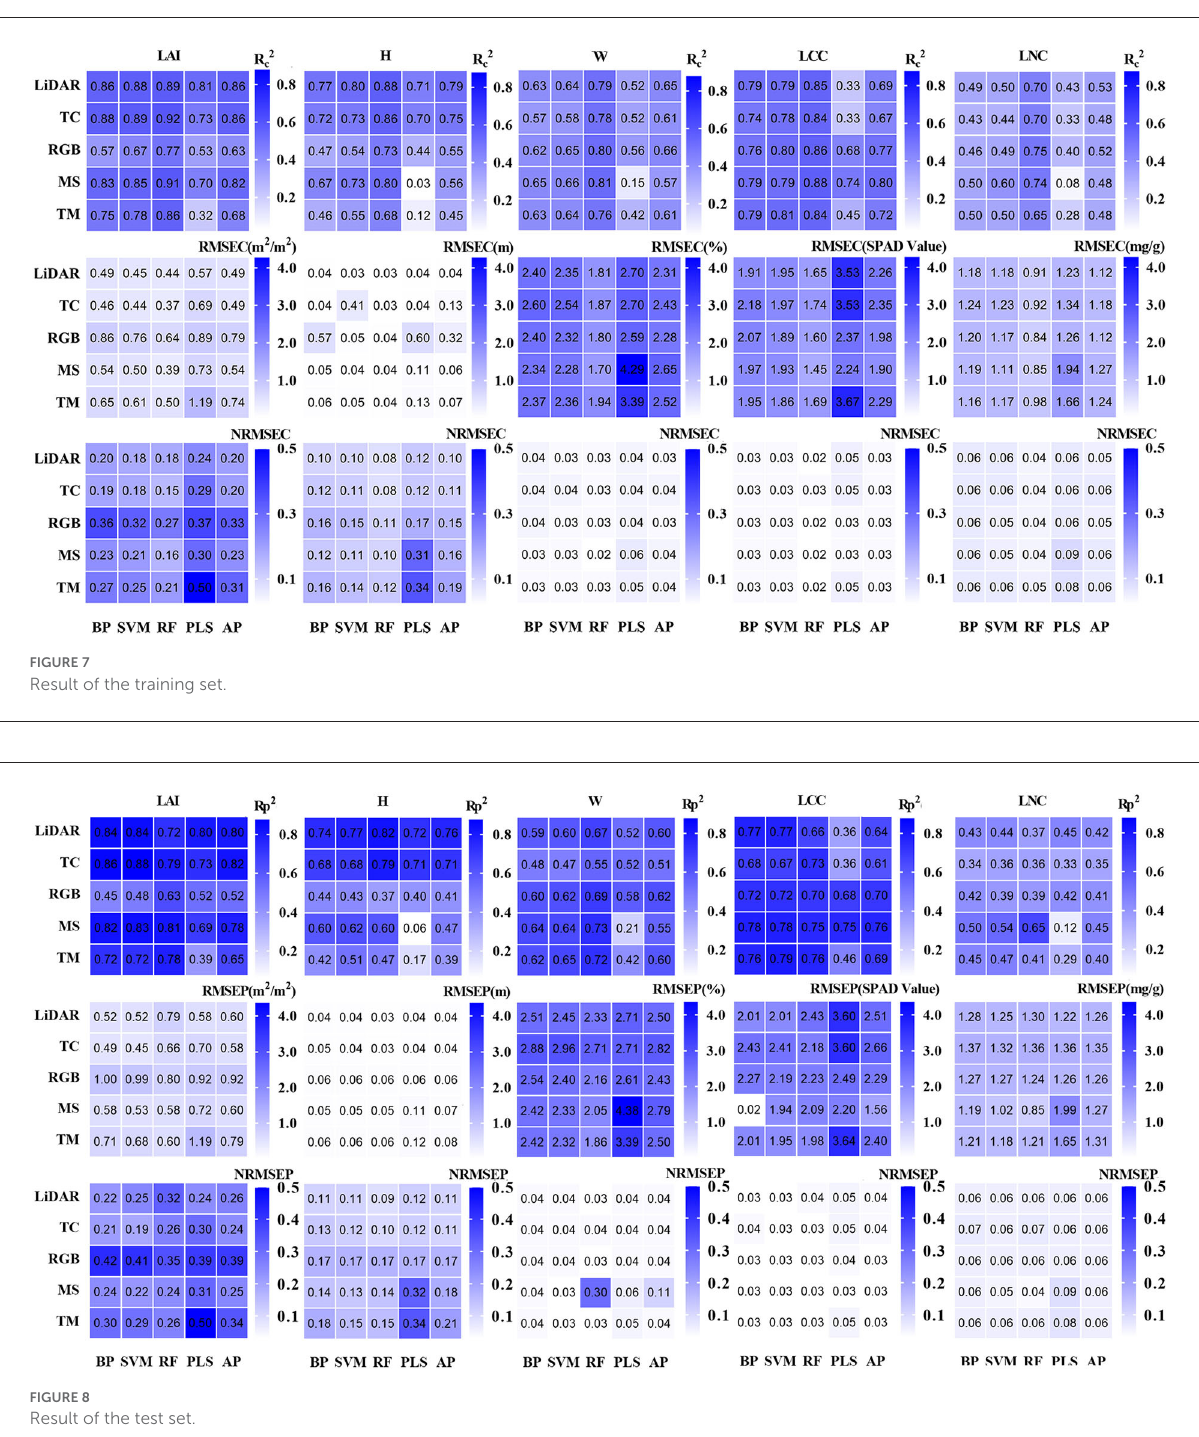
established by MS data has the highest accuracy (Rp 2 RMSEP 1.9, and NRMSEP =